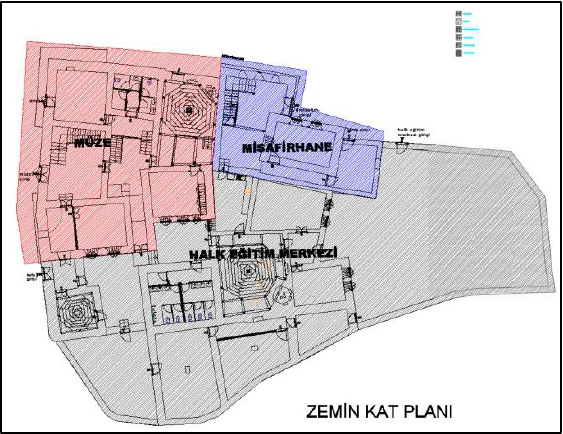
Figure 11. Restoration